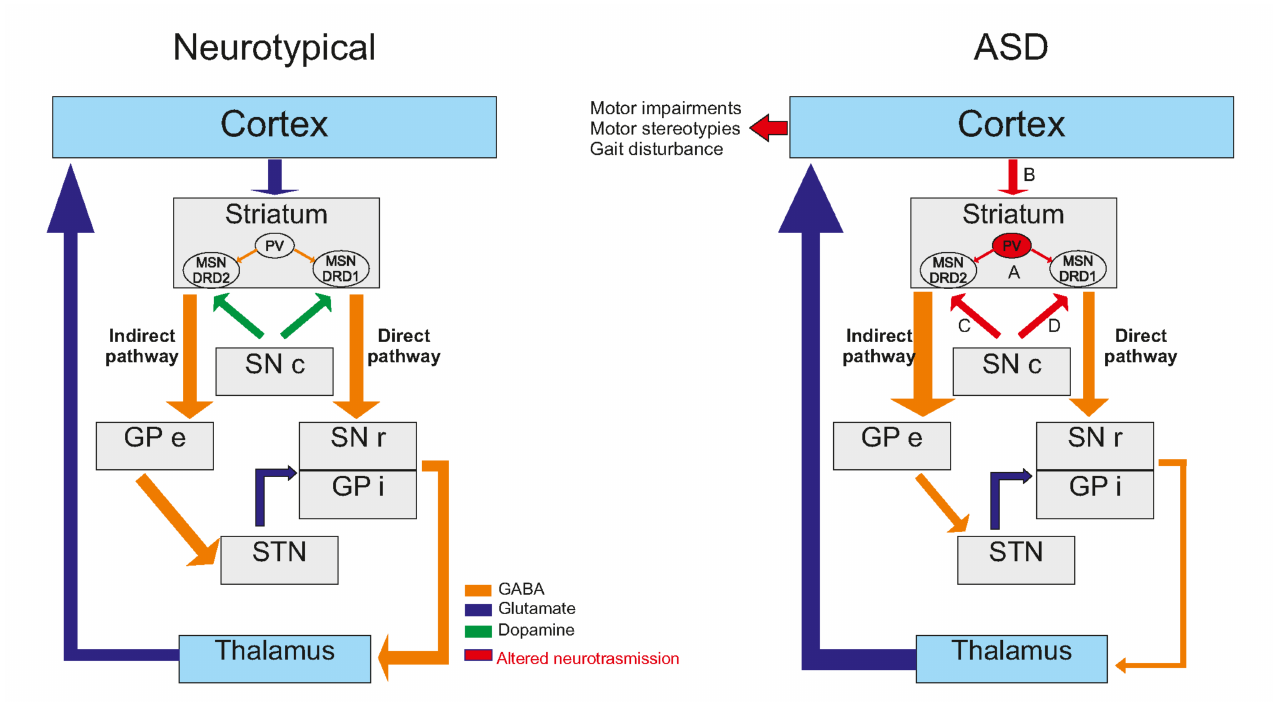
Figure 2. Basal ganglia modifications in ASD. Basal ganglia network is shown to be deeply affected in ASD models. The main alterations are found at 4 points of interest (A,B,C,D). Striatal local inhibition mediated by PV interneurons. (A) is altered in some ASD models like Shank1 − / − and Shank3B − / − mice [149], VPA mice [26] or Cntnap2 − / − mice [143]. Responsible of feed-forward inhibition, al- teration of these interneurons may lead to altered MSNs’ functionality. Interestingly, corticostriatal pathway (B) is widely described as altered in ASD models. For instance, in Ngln − / − mice, Ngln3 − / − mice, Shank3 − / − mice [150] or Shank2 − / − rats [151], alterations of the glutamatergic transmission onto MSNs are reported. Thus, alterations of plasticity were also highlighted in Shank3e4-22 − / − mice [91]. However, the dichotomy between direct and indirect pathway allows to highlight some pathway-specific alteration. On the one hand, some alterations were found to be specific of the indirect pathway (C), like an increase of DRD2 expression in the striatum, leading to a dopaminergic imbalance in favor of the indirect pathway [148,152]. On the other hand, some alterations were found to be specific to the direct pathway (D) as alteration of synaptic transmission has been highlighted in DRD1 MSNs but not DRD2 in NL3-cKO mice [153]. Thus, in Nlgn1 − / − mice, the AMPA/NMDA ratio was found to be reduced specifically in direct pathway MSNs [154], leading to an altered